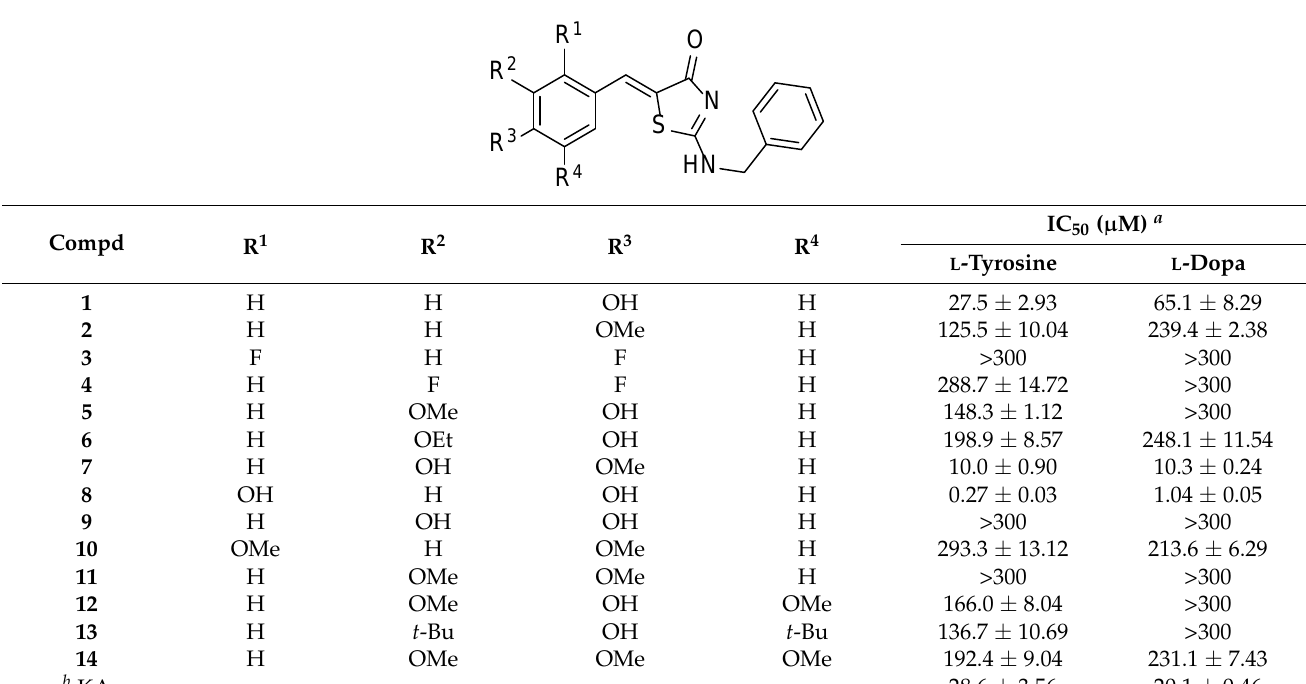
Table 1. Half-maximal inhibitory concentration (IC 50 ) values of ( Z )-2-(substituted benzylamino)-5-